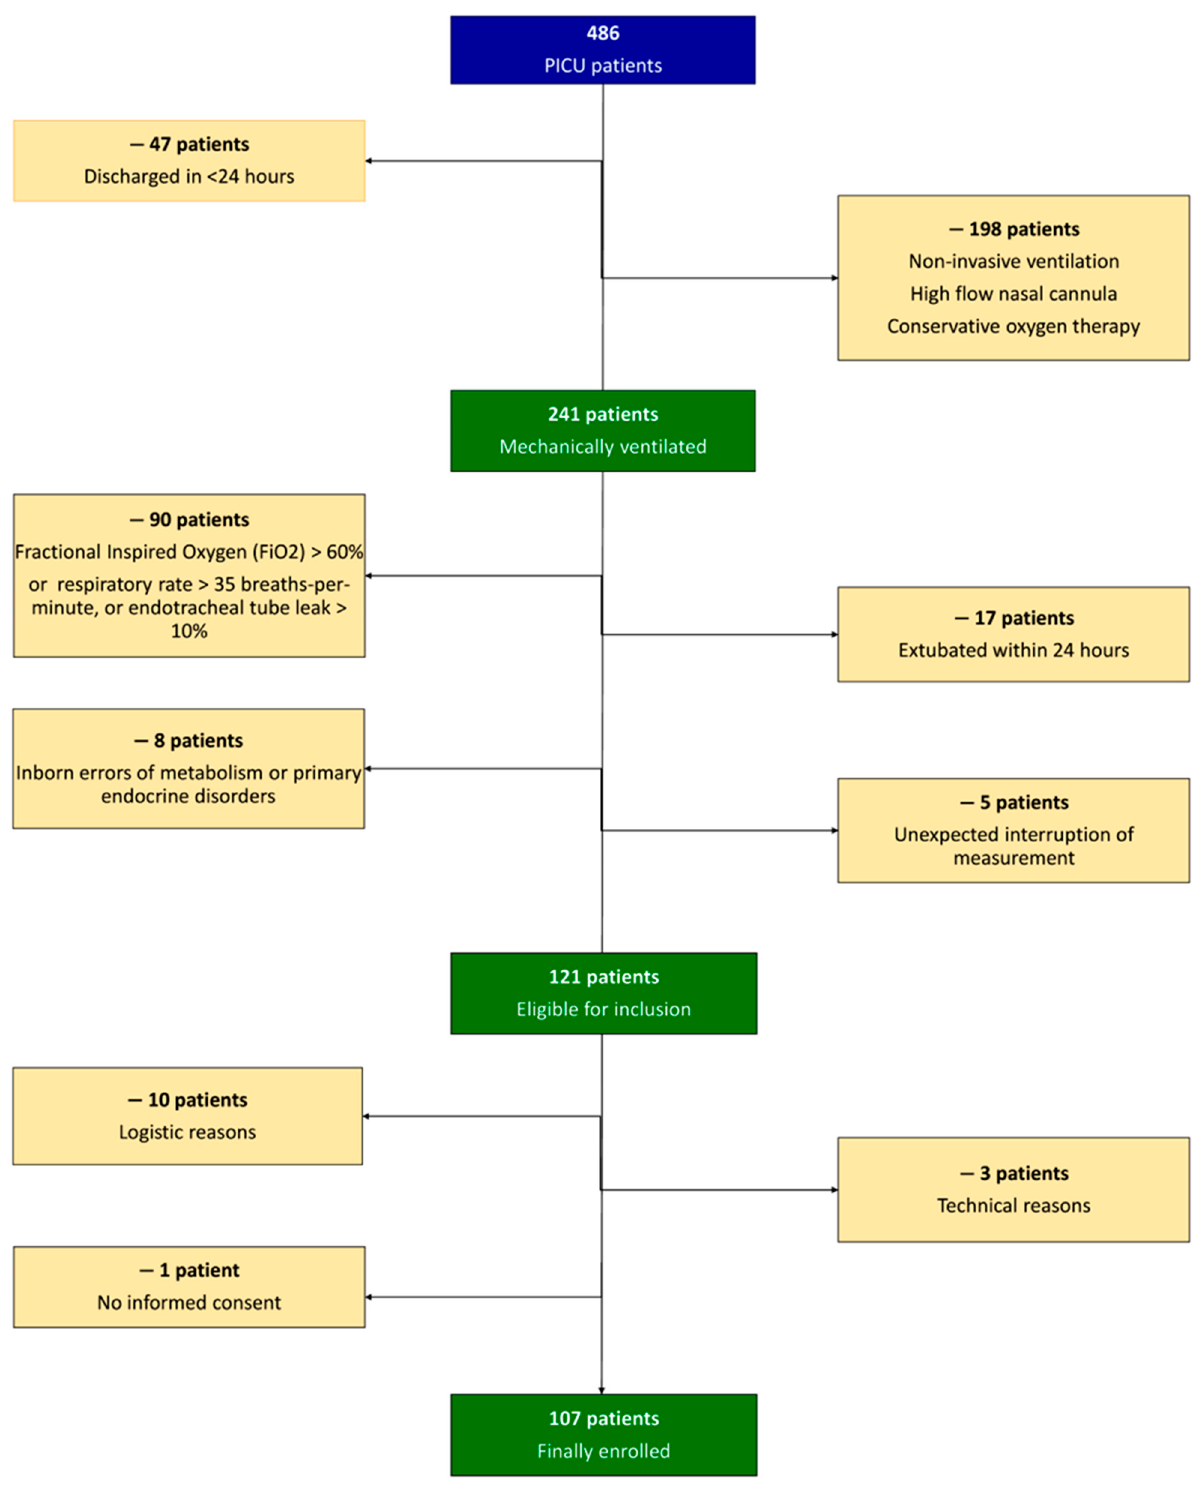
Figure 1. Flow chart.